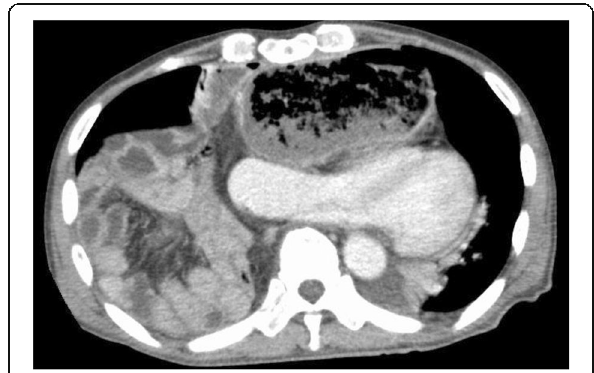
Fig. 1 Computed tomography findings of case 1. The axial image demonstrated that the intestine had been drawn into both thoracic cavities. The intestine pressed the gastric conduit, leading to obstruction and dilation. This dilated gastric conduit severely pressed the heart